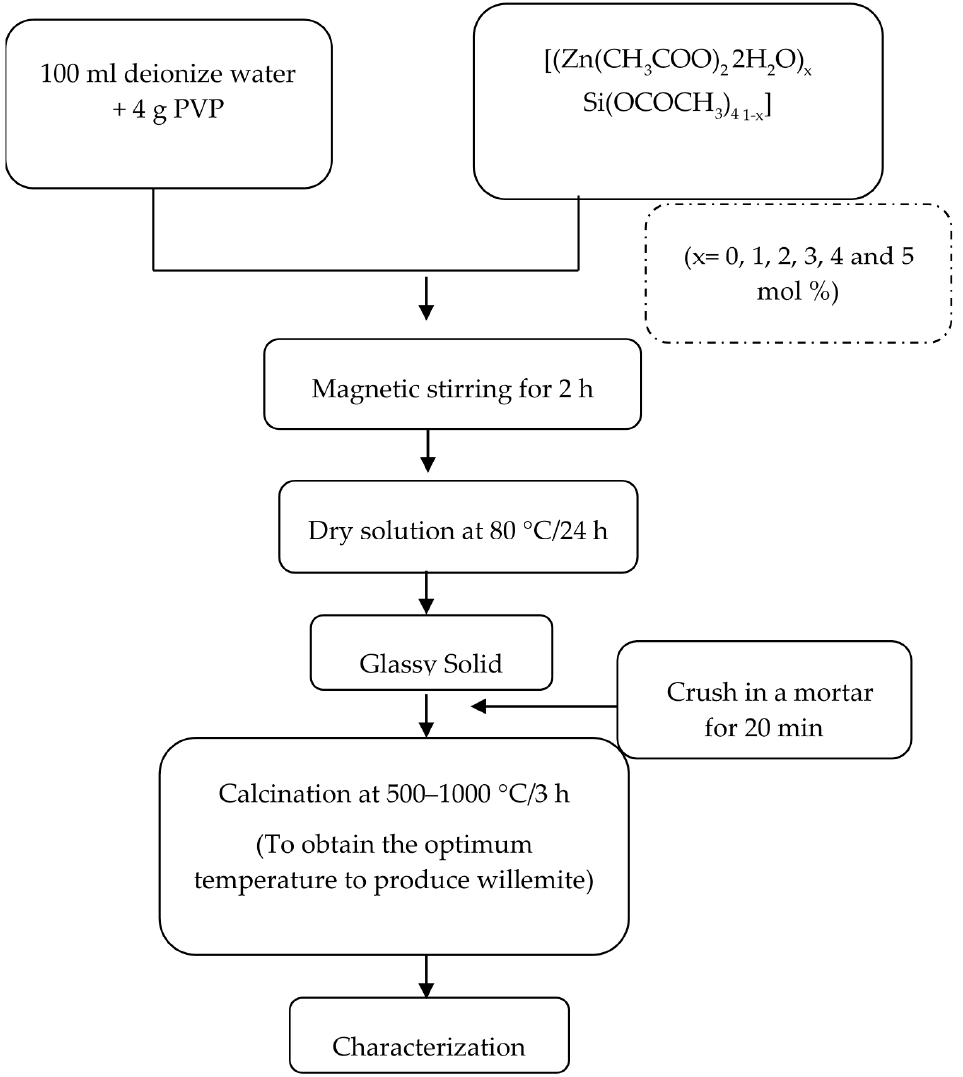
Figure 1. Schematic diagram of the synthesis process.